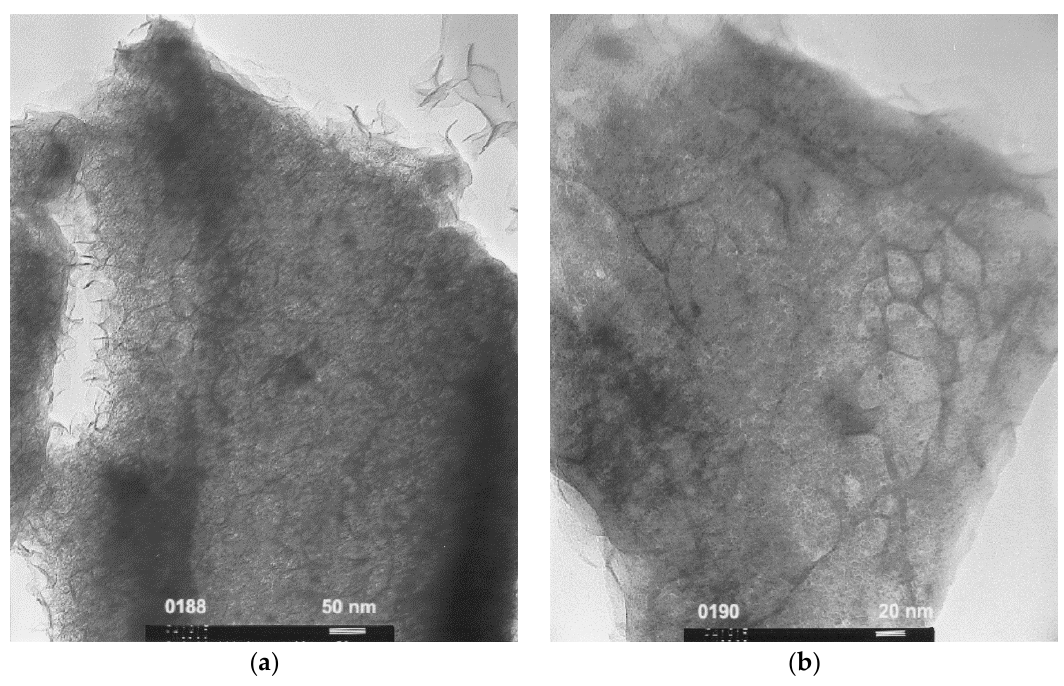
Figure 7. Transmission electron microscope (TEM) micrographs at ( a ) × 100,000 and ( b ) × 200,000 magnifications of the AR3 powder made by MS + MA at different magnifications. The cellular structures seen in the micrographs are from the cross-section of a sponge-scroll type of microstructure. Areas with darker contrast represent the scroll-type denser regions.